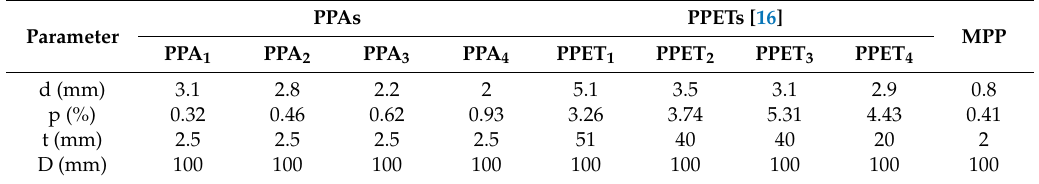
Table 1. Optimization parameters of three sound absorption